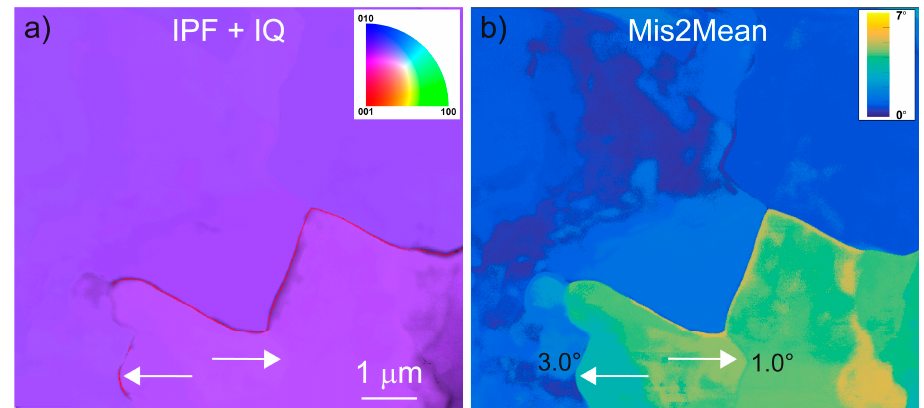
Figure 2. M642 subgrain boundaries (SGB; indicated by white arrows). ( a ) IPF corresponding to the direction perpendicular to the plane of view superimposed with the IQ (Equation (1)); color code inserted ( Pnma ). The subgrain boundary is highlighted by a red line. ( b ) Mis2Mean map corresponding to ( a ), up to 7°. Misorientation angles are indicated next to the boundary arrows.